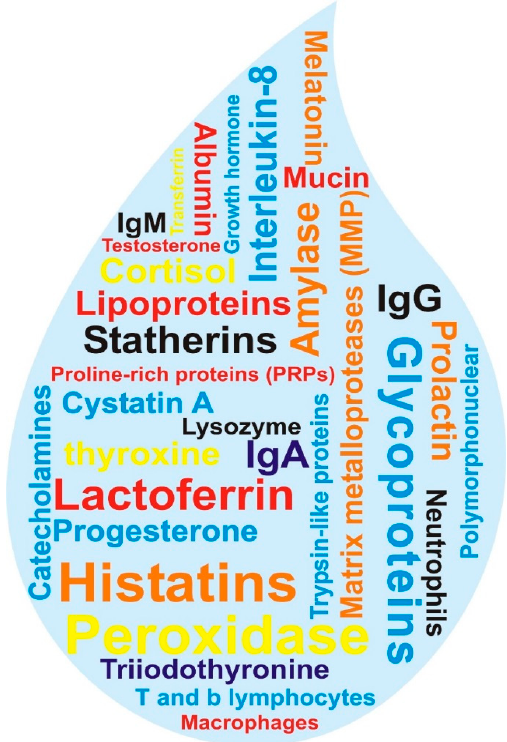
Figure 1. Illustration representing human salivary drop proteins and peptides.